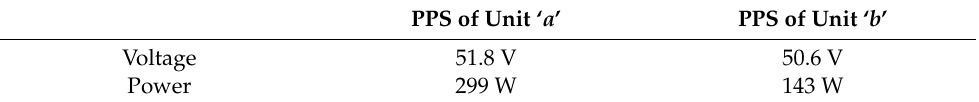
Table 4. The voltage and power measured at the terminals of the programed power supplies (PPS).